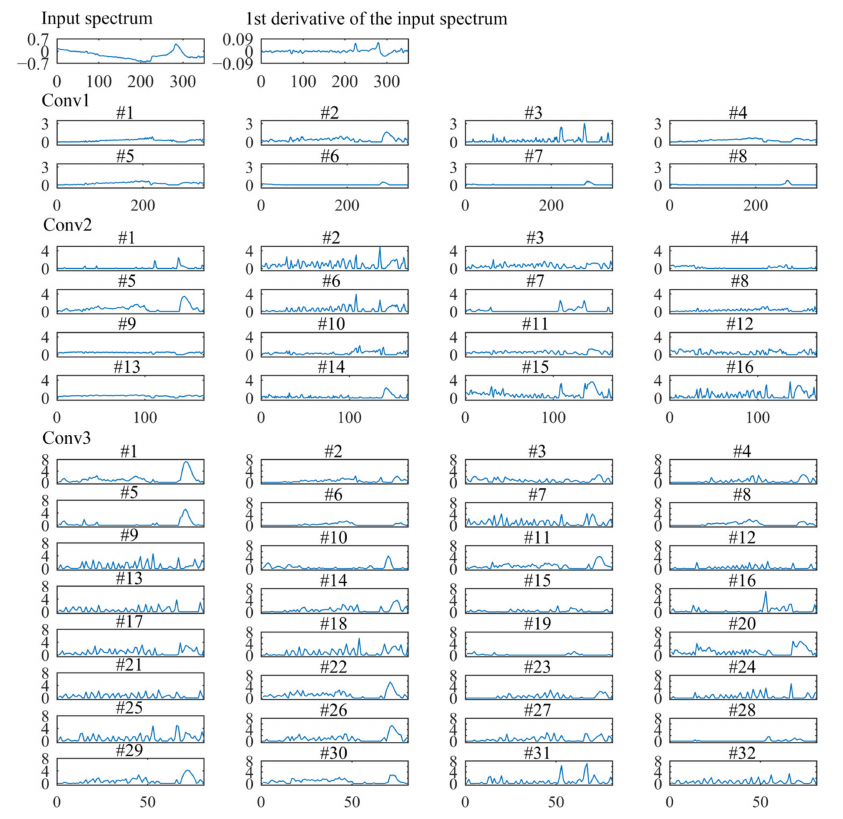
Figure 6. Visualization of the input spectral, the first derivative of the input spectral, and the feature maps of each convolutional layer for the spectrophotometer